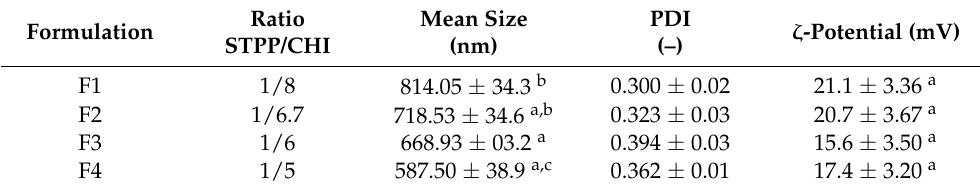
Table 2. Physicochemical parameters of surfactant-polyelectrolyte complexes.